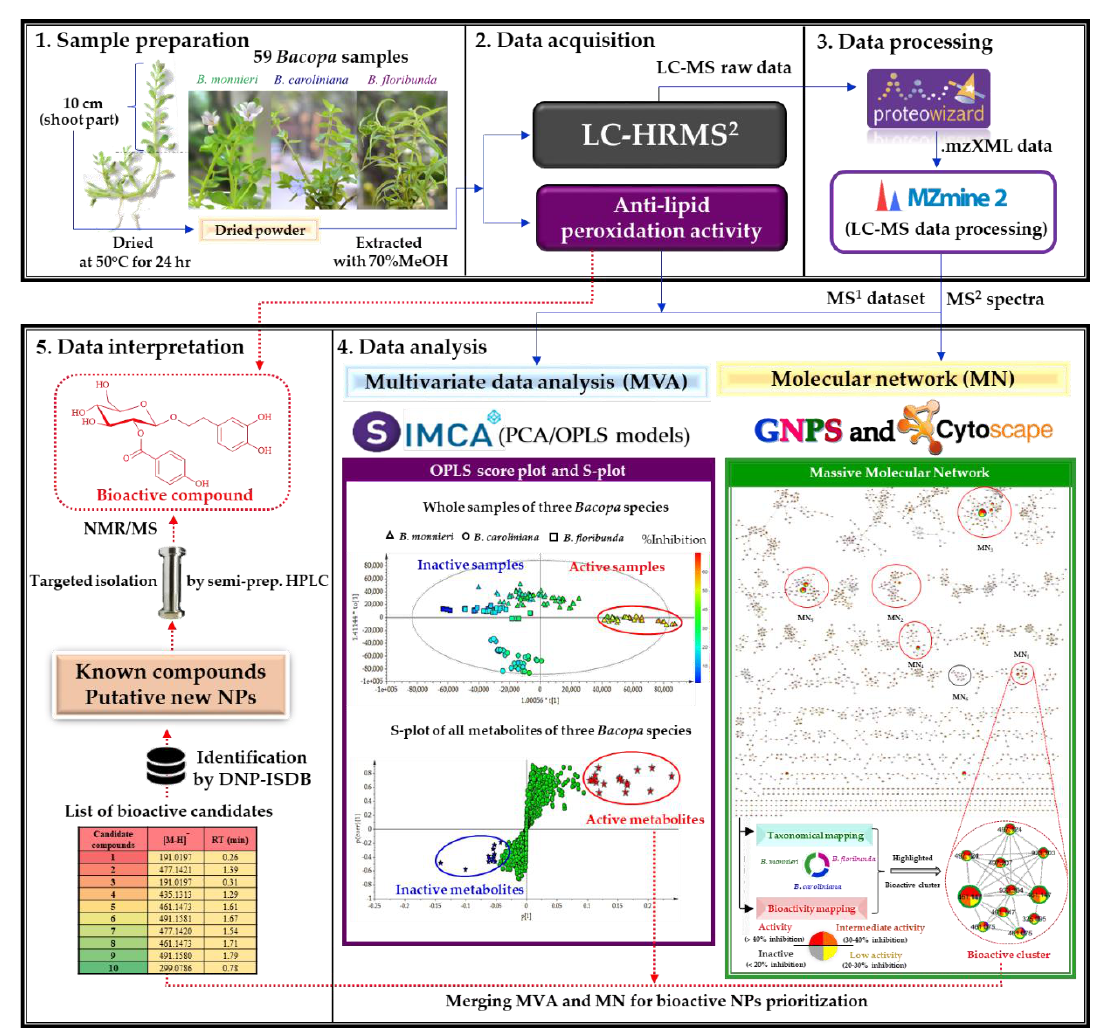
Figure 1. Schematic diagram of lipid peroxidation inhibitor discovery from LC-HRMS 2 analyses of 59 Bacopa extracts combining metabolomics MVA and multi - informative MN.